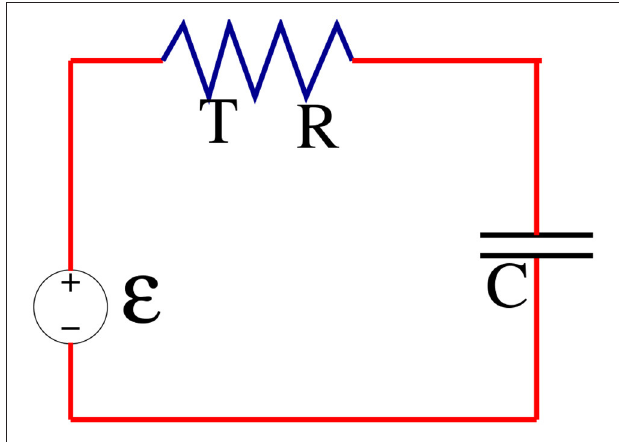
FIGURE 2 | RC-circuit with resistor at temperature T , the electrical (linear) circuit equivalent of the basic Langevin equation. The thermal noise at the resistor produces a fluctuating potential, following the Johnson–Nyquist